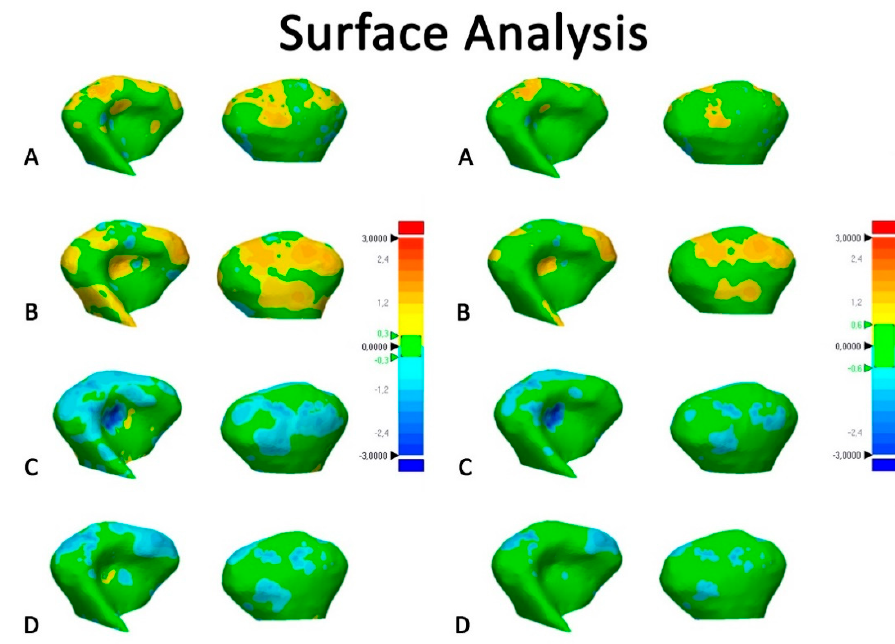
Figure 6. Surface-based deviation analysis between 3D condylar models obtained with semi-automatic segmentation and its ground truth model (manual segmentation). ( A ), Invesalius; ( B ), Dolphin 3D; ( C ), ITK-Snap; ( D ), Slicer 3D. The green of the color scale bars represents the range of tolerance. Left side: Color map set to a range of tolerance of ± 0.3 mm. Right side: color map set to a range of tolerance of ± 0.6 mm.